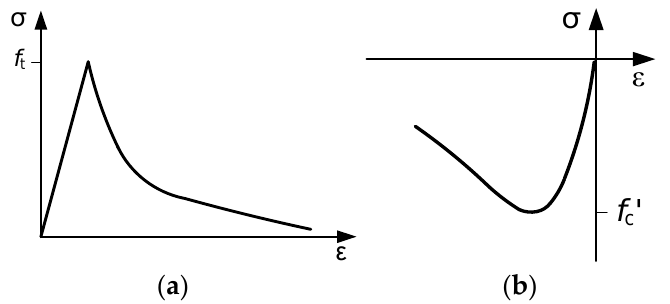
Figure 3. Constitutive models for concrete in tension and compression: ( a ) Hordijk model in tension; ( b ) Maekawa model in compression.